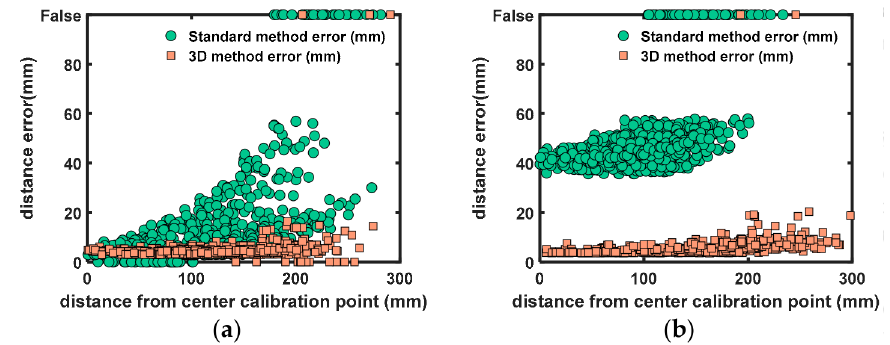
Figure 11. Scatter plots with differences between the measured laser spots and the input laser spots in relation with the distance to the center calibration point. “False” values are laser spots that are not detected (out of search range). ( a ) Distance errors (mm) when the barrel was not moved after 2D calibration. ( b ) Distance errors (mm) when the barrel was moved 1 m away from the original